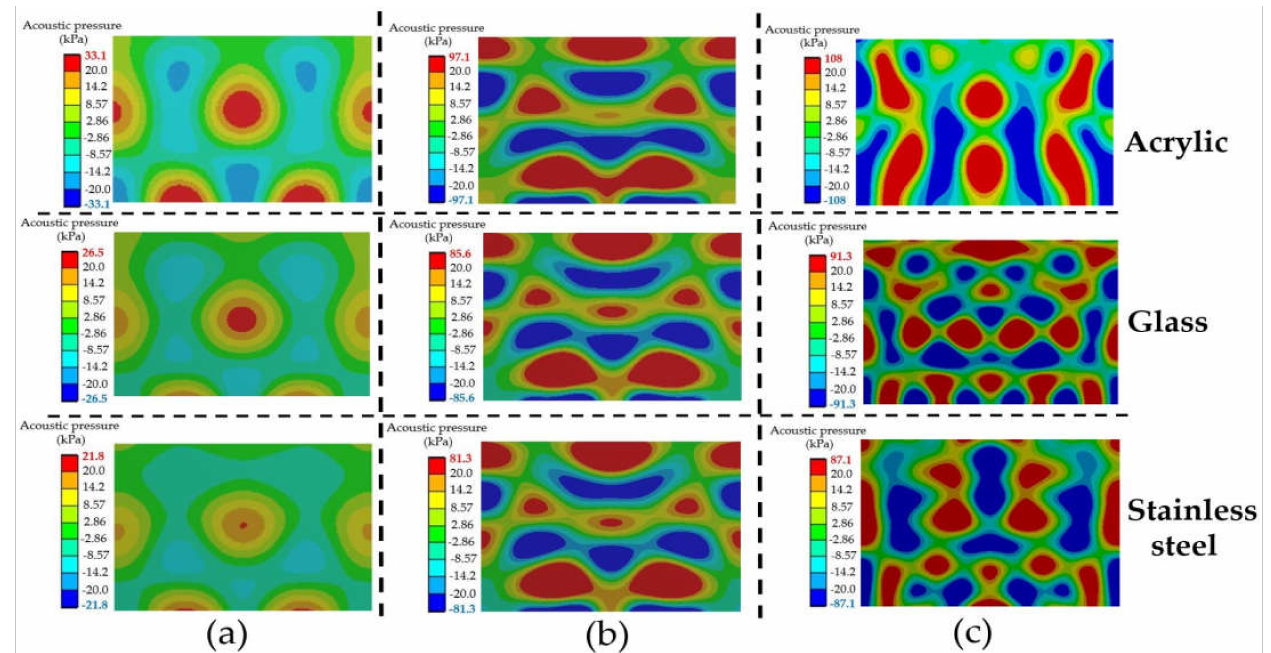
Figure 16. The acoustic pressure distribution pattern for varying tank body materials with transducers of ( a ) 15 kHz, ( b ) 28 kHz, and ( c ) 40 kHz.